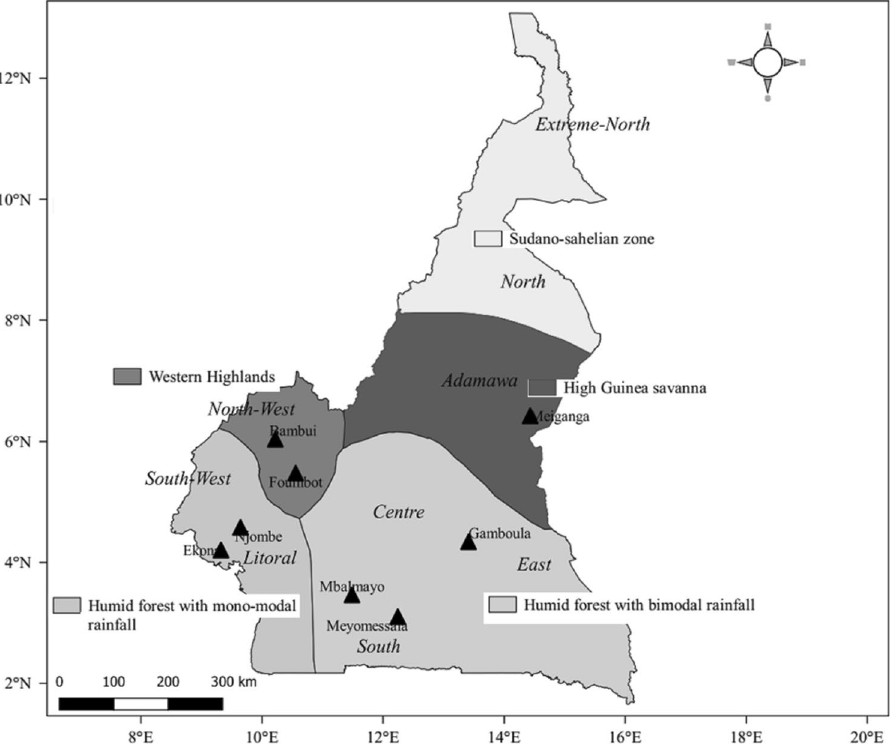
Figure 5. Locations of the cassava multilocation trial (Arcgis V10.3.1, https:// deskt op. arcgis. com/ en/